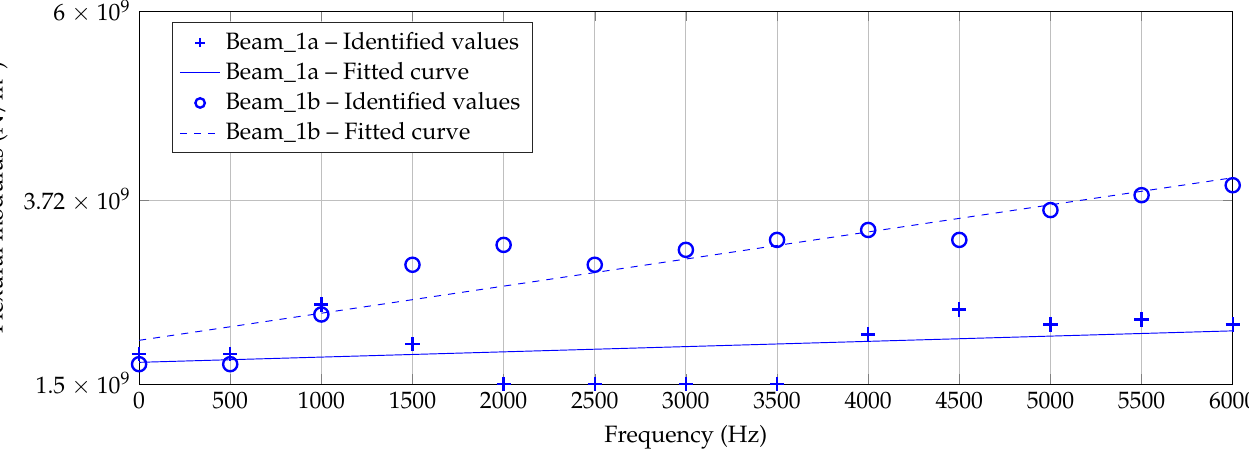
Figure 15. Identified flexural moduli by Figure 12 for Beam_1a/b with fitted linear